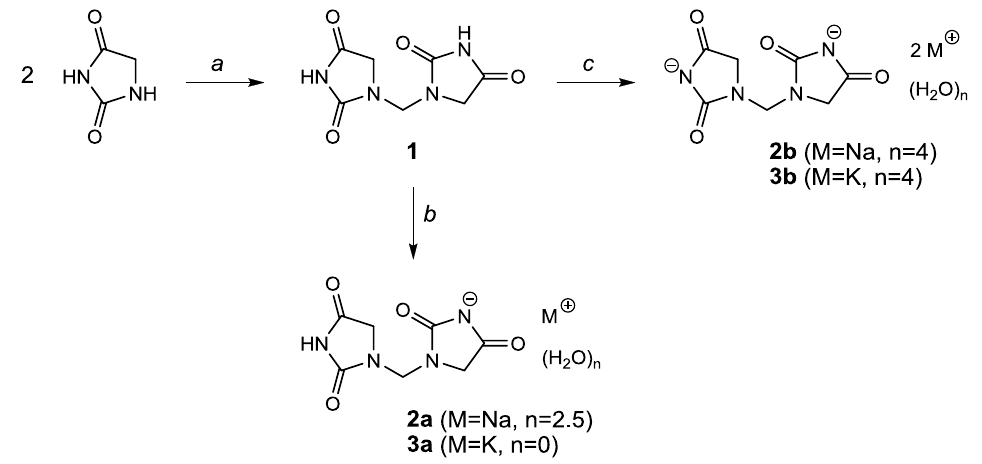
Figure 1. Synthesis of 1,1′-methylenebis(imidazolidine-2,4-dione) and its salts. Reagents and solvents: a : CH equivalents NaOH or KOH in H